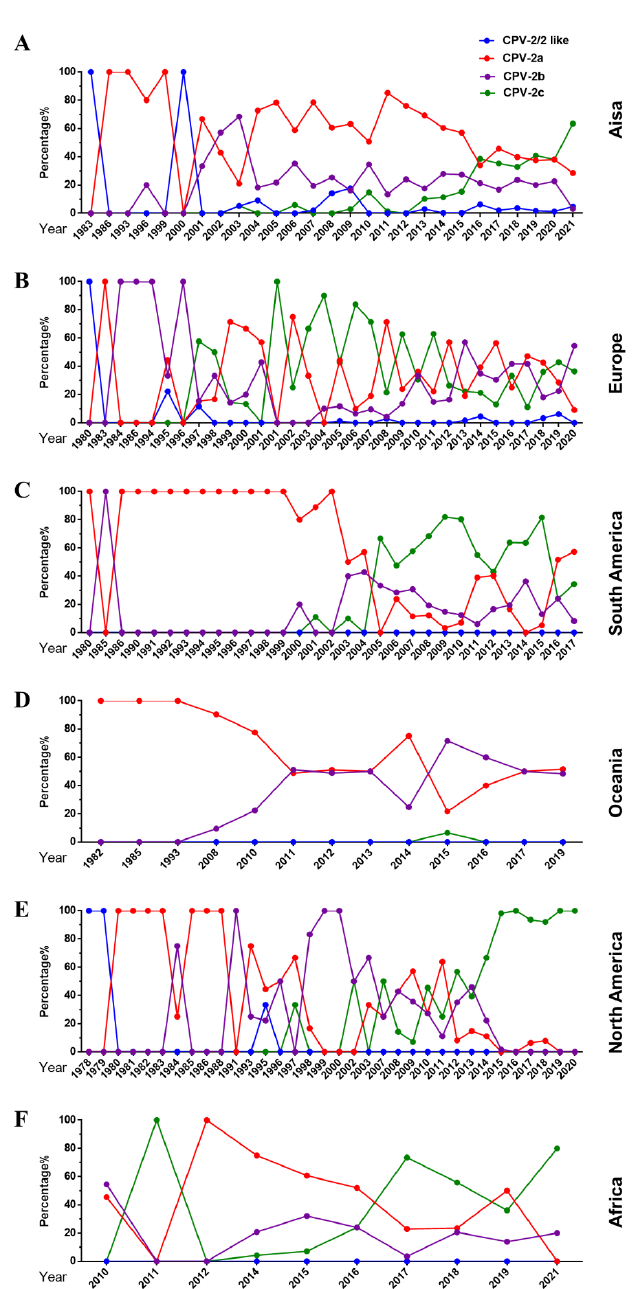
Figure 4. Changes in the proportion of CPV-2a/2b/2c on each continent. ( A – F ) The proportion of different variants on each continent over time.